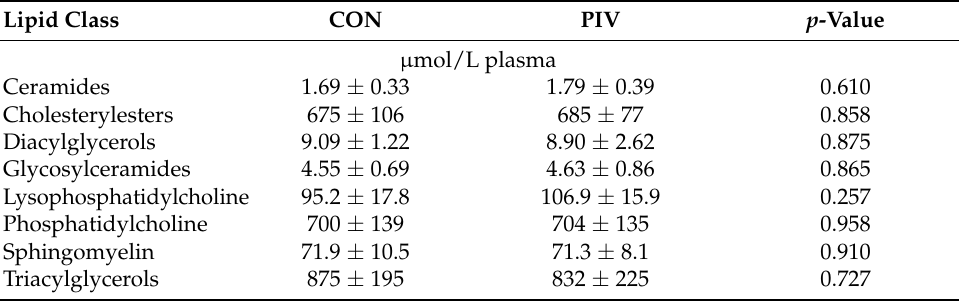
Table 1. Concentrations of important lipid classes in plasma of 5-week-old pigs orally administered either vehicle (group CON) or pivalate (group PIV) for 28 days as determined by targeted metabolomics.